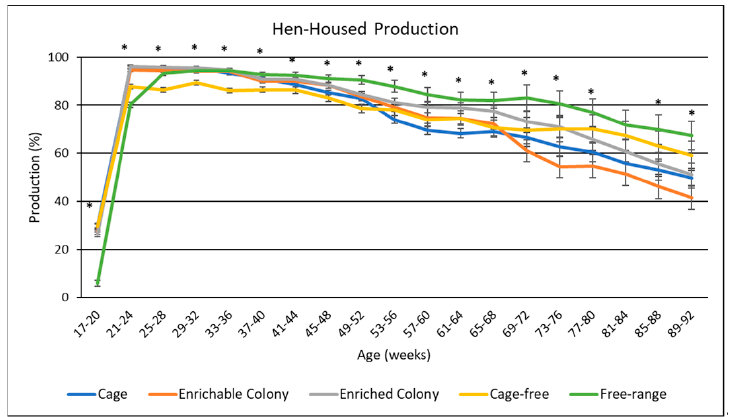
Figure 2. The effect of housing environment on hen – housed production of brown egg layers by age. * Signifies a significant effect ( p < 0.05) of housing environment during that age range.